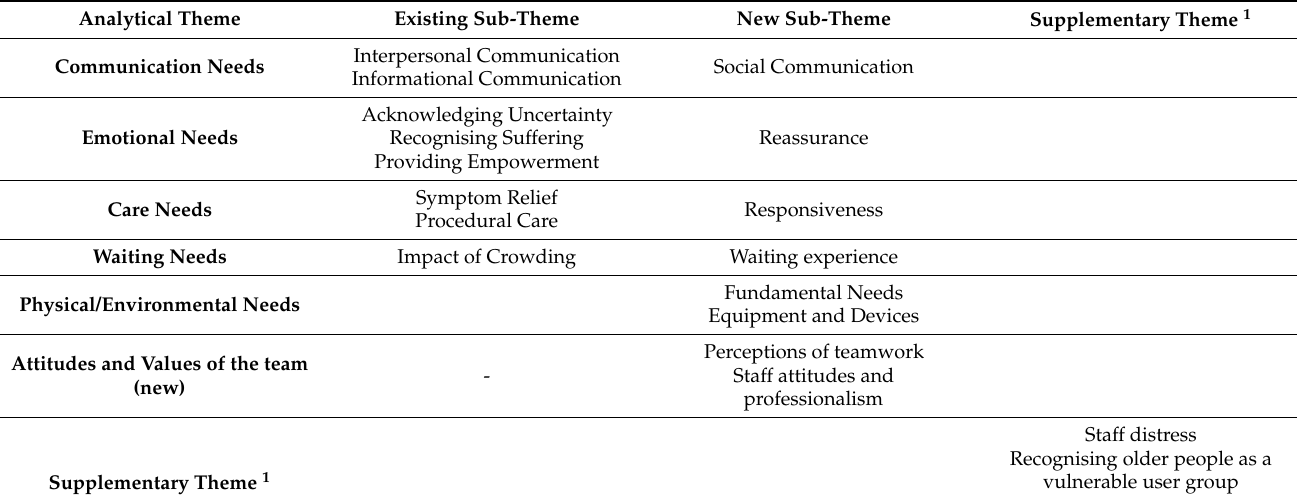
Table 3. Analytical themes and